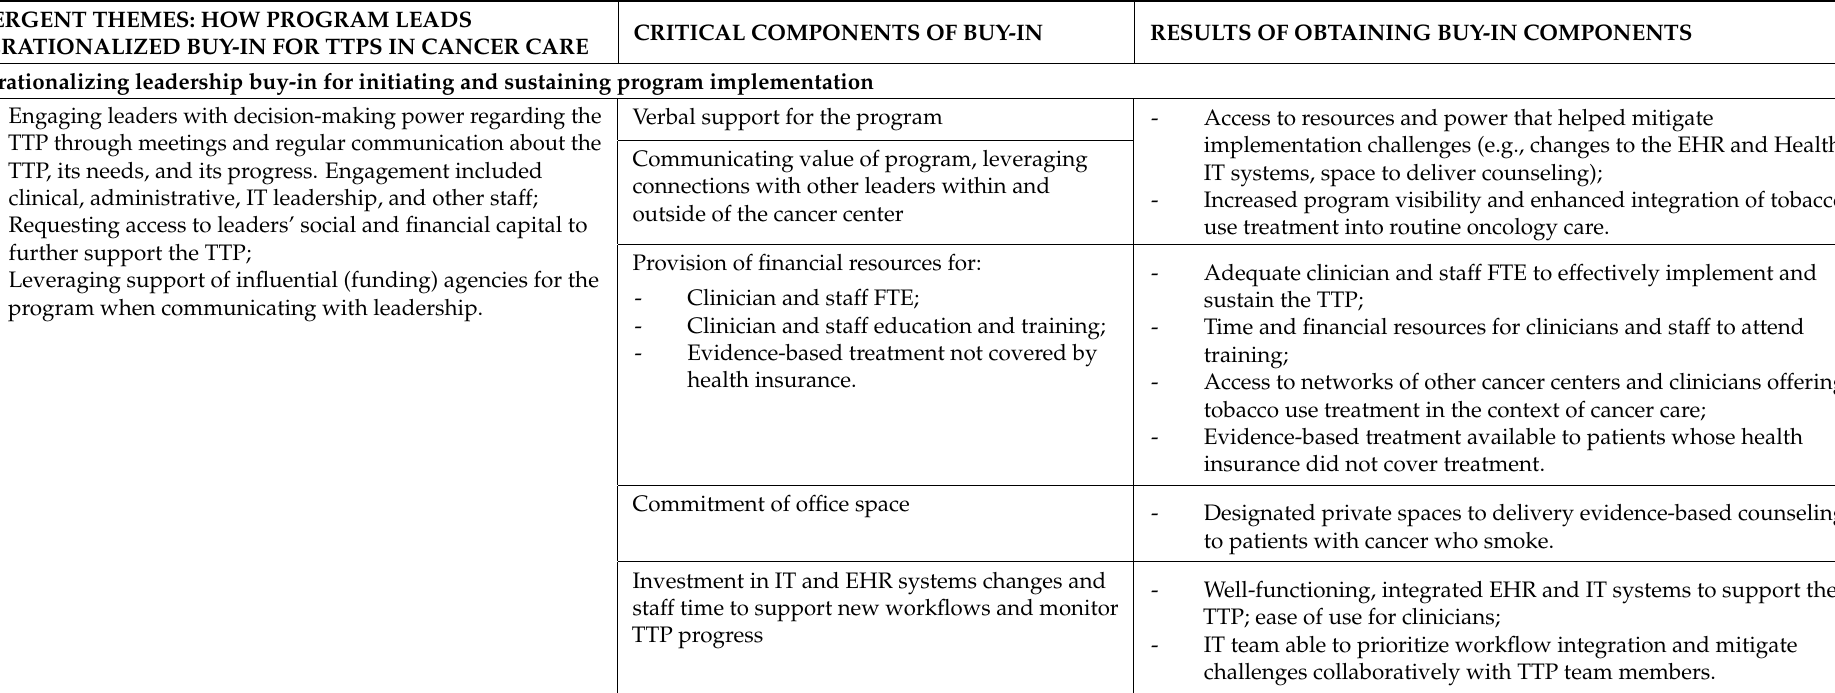
Table 3. Defining buy-in and its consequences for tobacco dependence treatment programs in oncology care